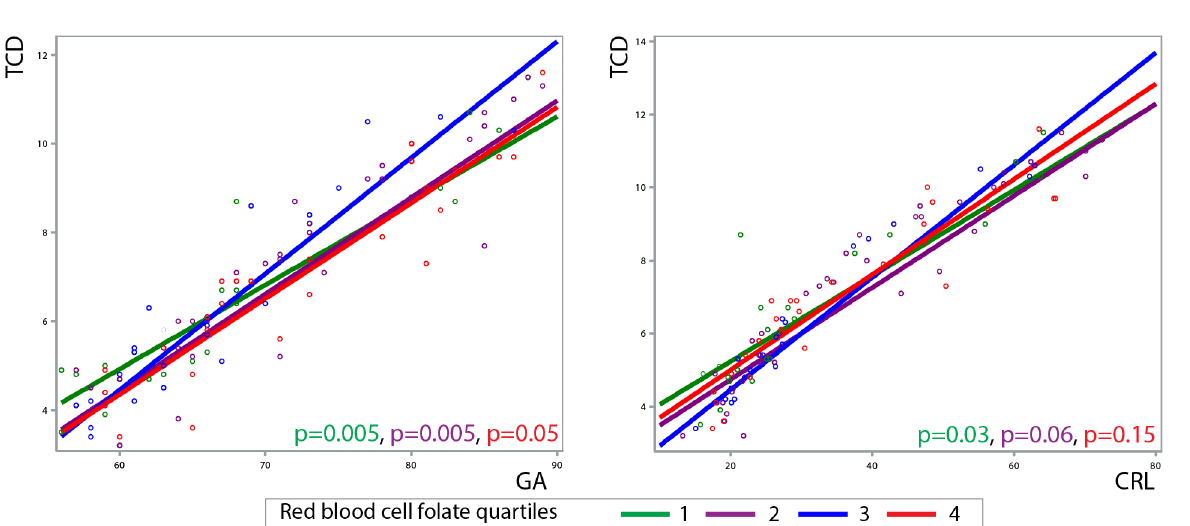
Fig 3. Associations between periconceptional red blood cell folate quartiles and cerebellar growth trajectories. Linear mixed models representing the effects of red blood cell folate quartiles on cerebellar growth trajectories as a function of CRL in millimetres and GA in days. The blue line represents the third quartile used as